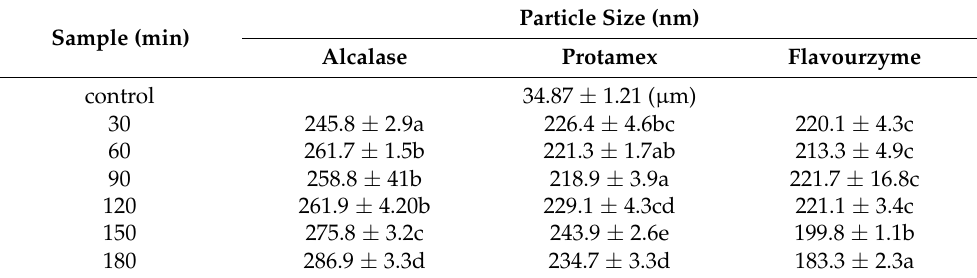
Table 2. Particle size of MPC hydrolysates by Alcalase, Flavorzyme, and Protamex. Sample